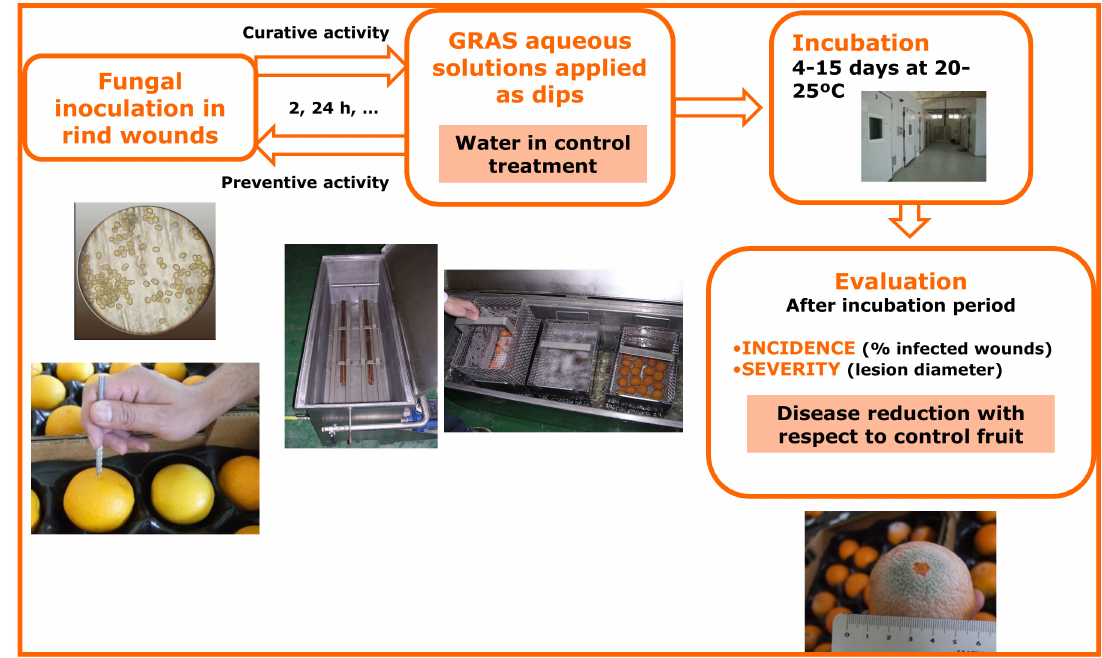
Figure 1. Methodological procedure for evaluating in small-scale trials the ability of dips in aqueous solutions of generally recognized as safe (GRAS) salts to control postharvest green mold of citrus caused by the fungus Penicillium digitatum